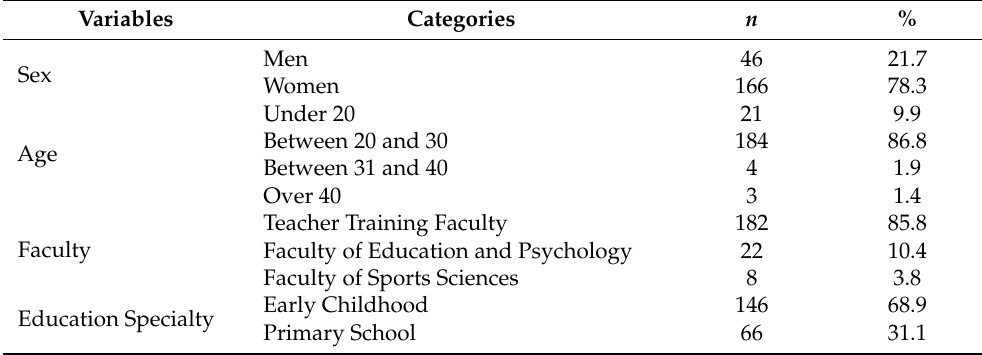
Table 1. Sociodemographic characteristics of the sample ( n =